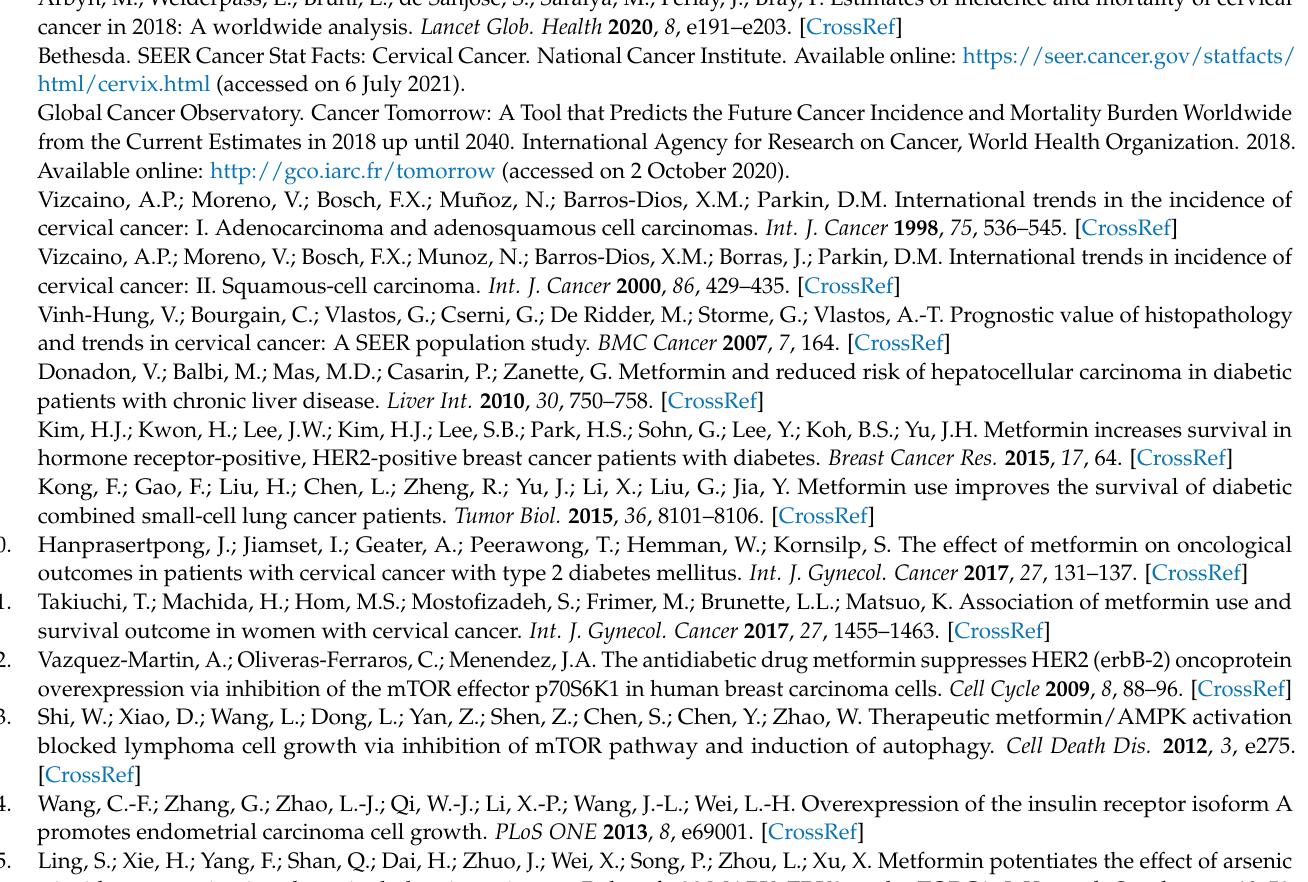
Figure S2: Metformin and everolimus activates mitochondrial and caspase-mediated pathways; Figure S3: Metformin and everolimus regulated PI3K/AKT and JNK/p38 MAPK signaling pathways; Figure S4: Caspase-3 and p38 MAPK involves metformin- and everolimus-induced